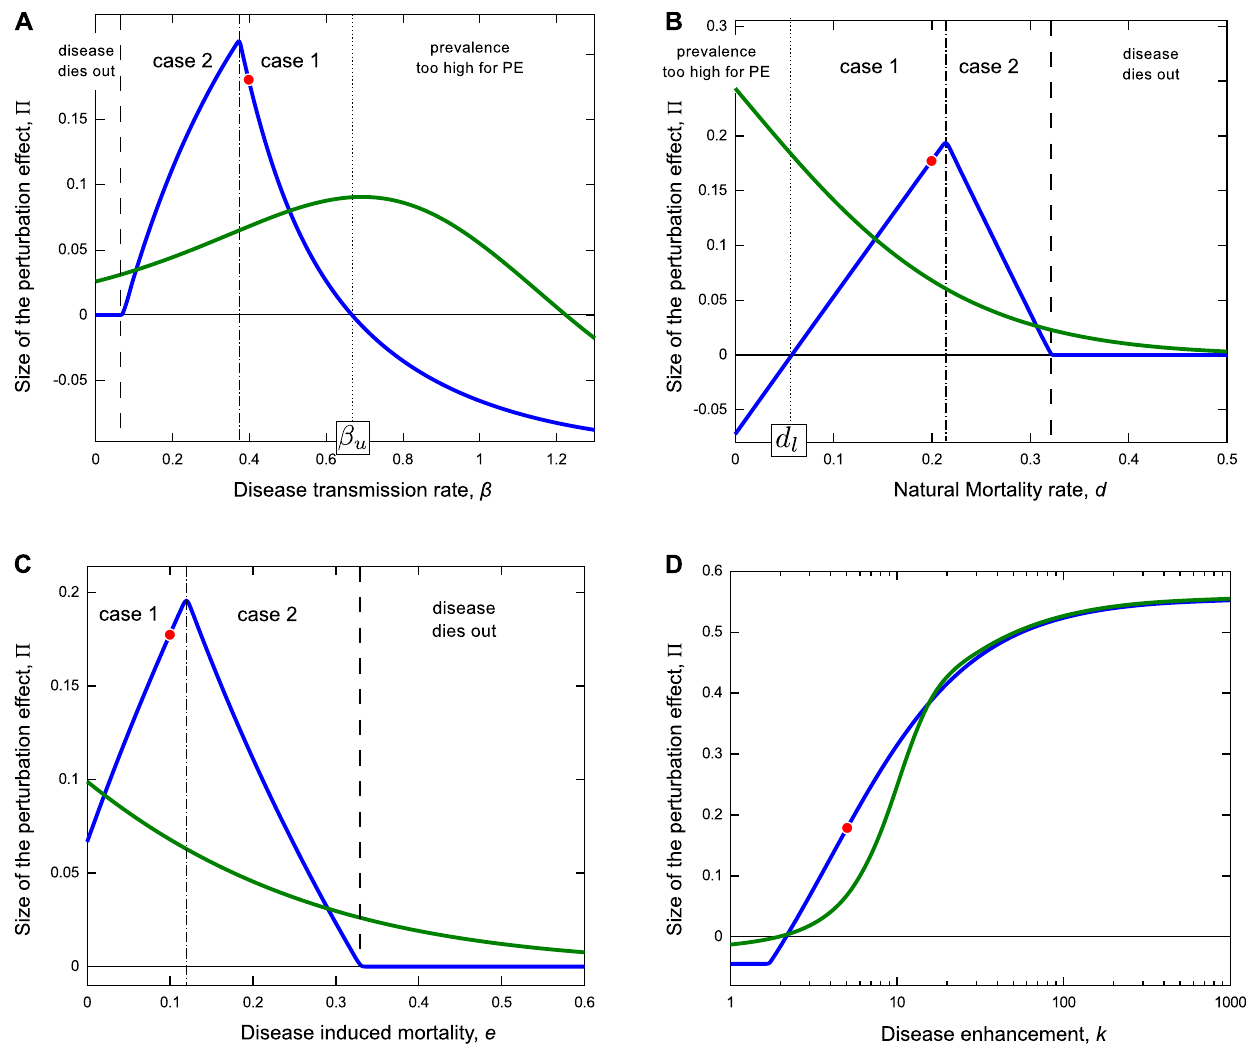
Figure 2. Sensitivity analysis of the persistent and transient perturbation effects in the deterministic model. Parameter values as in Table 2 and marked by a red dot when explicitly varied, the transient perturbation (green) is shown for t =5, the persistent perturbation (blue) P eqm is evaluated at t ~ 1,000 . The transient perturbation: (A) has an optimum for intermediate b , decays with (B) natural and (C) disease induced mortality, and (D) increases with k . With the exception of (D), the behaviour of the persistent perturbation is more complex. In (A) to the left of I (cid:2) ( p ) ~ 0 (dashed vertical line) b is low and there is no perturbation ( I (cid:2) ( p ) v 0 ). To the right of I (cid:2) ( p ) ~ I (cid:2) (0) (dotted vertical line corresponding to upper bound b u , see text) the prevalence in the absence of culling is sufficiently high to prevent a perturbation. The central region between I (cid:2) ( p ) ~ 0 and I (cid:2) ( p ) ~ I (cid:2) (0) is divided by a third vertical line I (cid:2) (0) ~ 0 (dot dashed), independent of k and p , into regions corresponding to case 1 ( I (cid:2) (0) w 0 ) where the disease persists the absence of population reduction, and case 2 ( I (cid:2) (0) v 0 ) where it does not (see text for details). The maximum persistent perturbation occurs at this boundary. Under case 2, population reduction is sufficient to stabilise the endemic equilibrium. In (B) as natural mortality d increases from zero (moving left to right) I (cid:2) (0) decreases , and the pattern seen in (A) is reversed. Here the dotted vertical line I (cid:2) ( p ) ~ I (cid:2) (0) denotes the lower bound d l . (C) shows the impact of disease induced mortality e is similar to that of natural mortality, but the chosen parameter values mean that prevalence is never too high to prevent a perturbation effect. Note: dotted and dashed lines are reversed when k is too low for the perturbation effect to occur, leaving no room for cases 1 and 2. See Fig. 4 for analogous spatial model results.